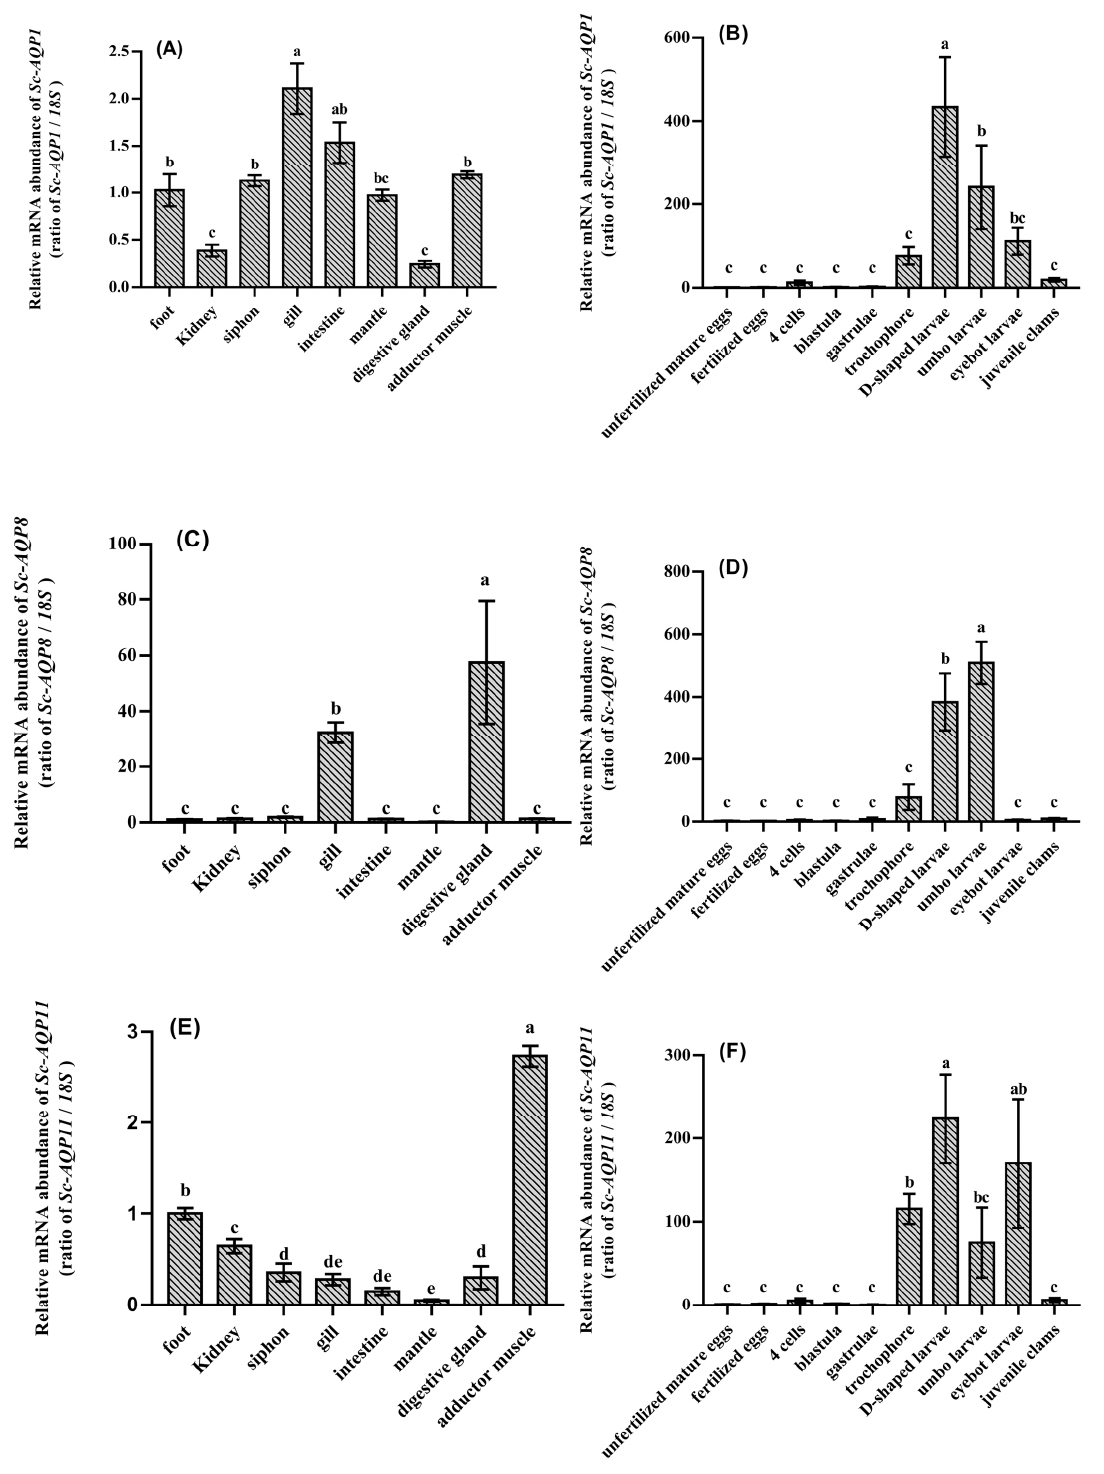
Figure 5. Quantitative expression analysis of Sc-AQP1 , Sc-AQP8 , and Sc-AQP11 in different tissues ( A , C , E ) and developmental stages ( B , D , F ). Vertical bars represent the mean ± SE ( n = 5) and mean ± SE ( n = 200) in tissues and developmental stages analysis, respectively. SE represents independent biological replicates. Data were statistically analyzed by using one-way ANOVA, followed by the LSD test. Bars with different letters are significantly different ( p < 0.01).